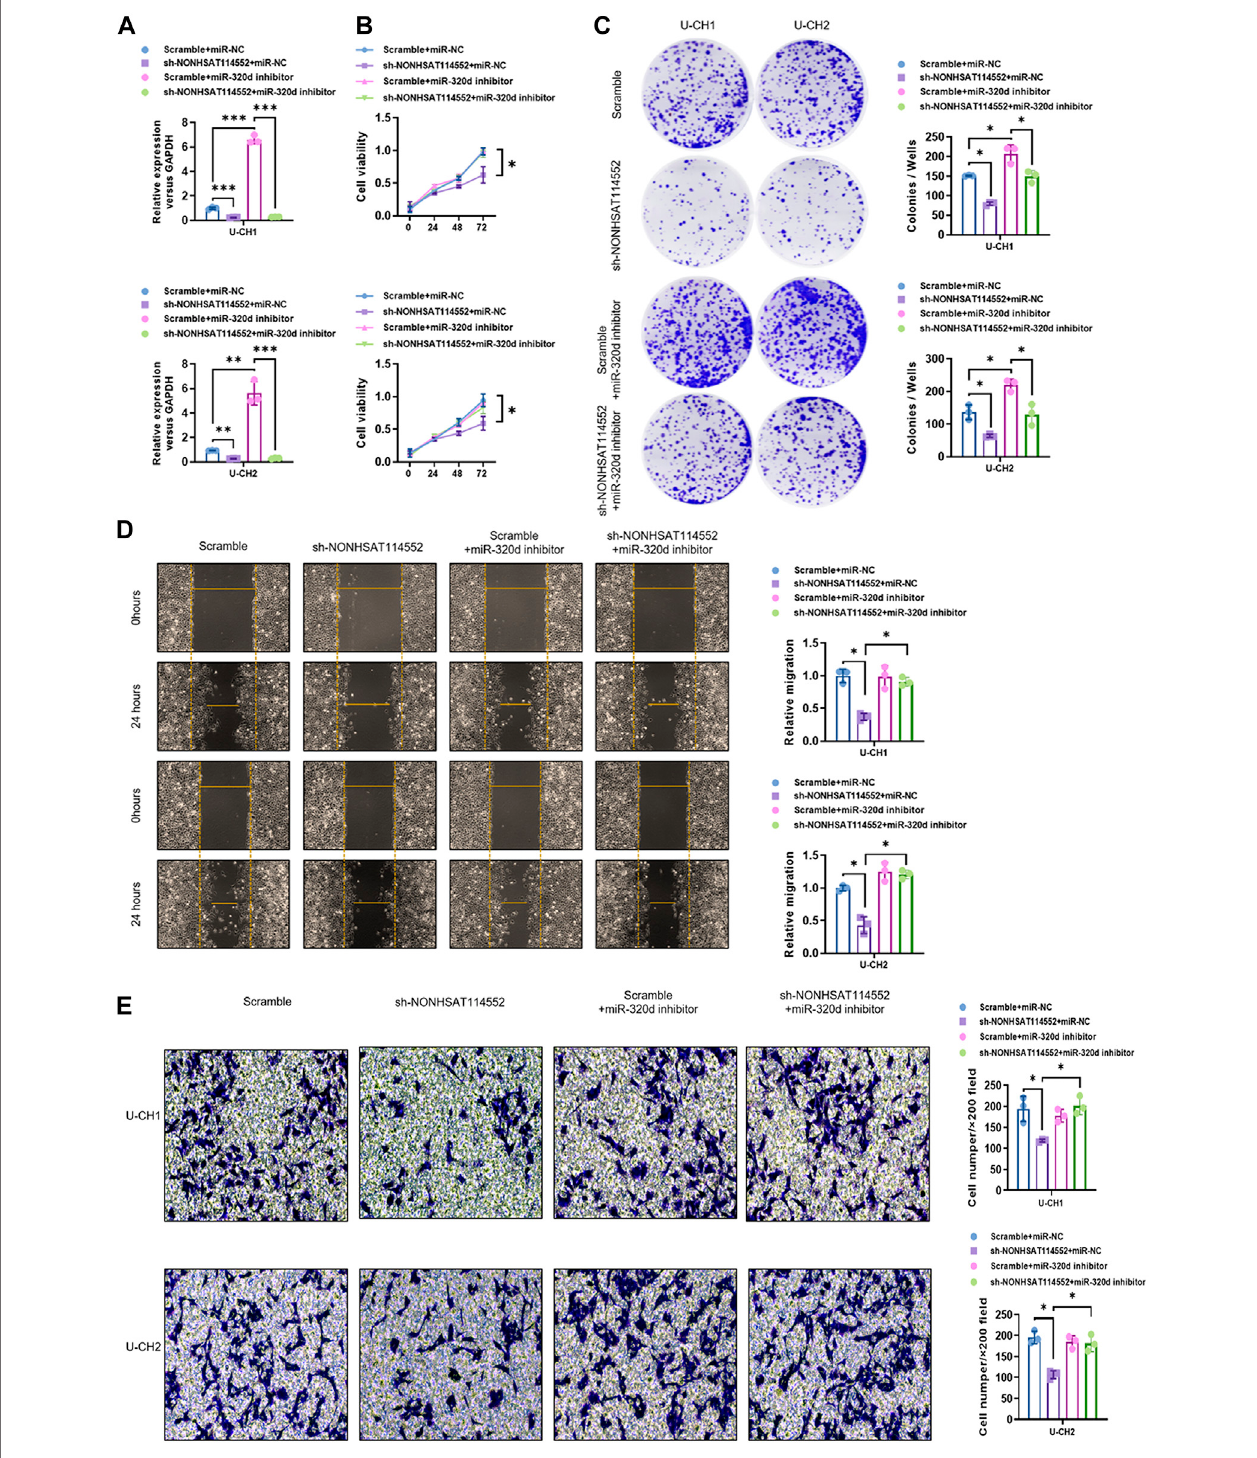
FIGURE 4 | miR-320d suppression rescued the effects of NONHSAT114552 knockdown on chordoma cell proliferation, invasion and migration (A) . NONHSAT114552mRNAexpressionwasmeasuredindifferentgroups (B) .CellviabilityofU-CH1orU-CH2cellsindifferentgroupswasdetectedbyCCK8 (C) .Colony ofU-CH1orU-CH2cellsindifferentgroupswasassessedbycolonyformationassays (D) .MigrationabilityofU-CH1orU-CH2cellsindifferentgroupswasevaluatedby wound healing assays (E) . Invasion ability of U-CH1 or U-CH2 cells in different groups was analyzed by Transwell assays.